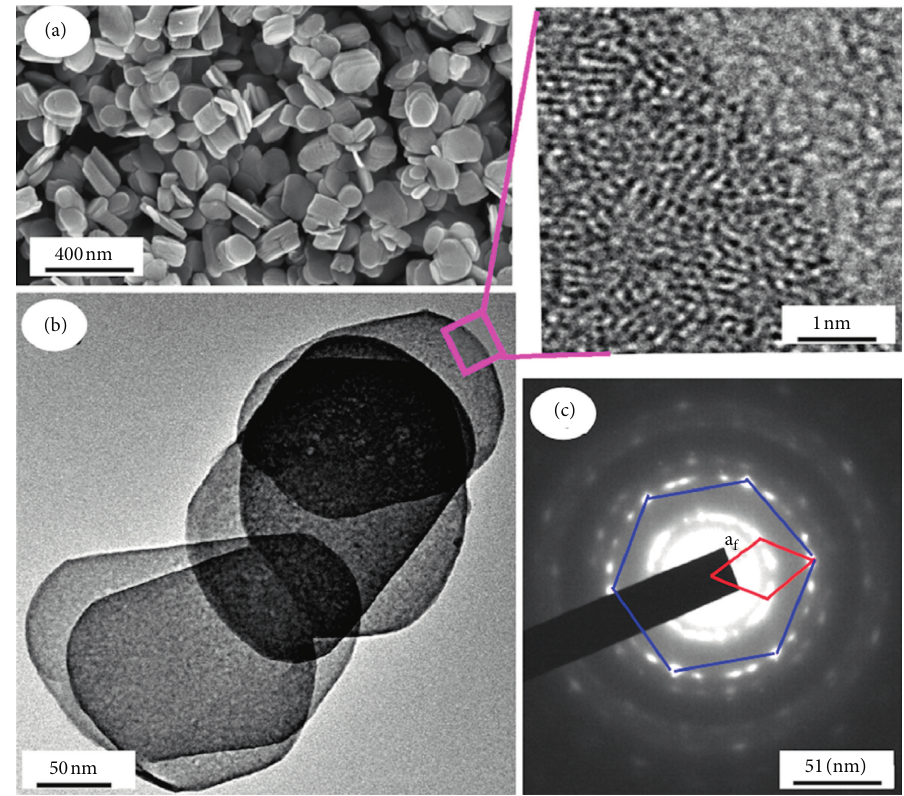
Figure 5: (a) SEM image of LEuH-Cl; (b) HRTEM of delaminated LEuH nanosheets, inset: a higher magnification at the edge of a single plate lying on a copper grid. (c) SAED pattern taken from an individual plate lying on a copper